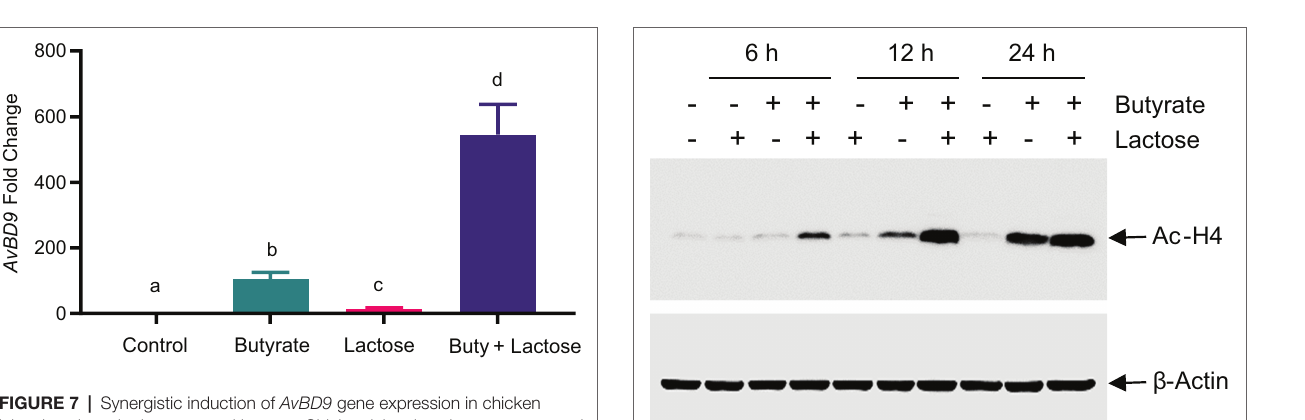
FIGURE 7 | Synergistic induction of AvBD9 gene expression in chicken jejunal explants by butyrate and lactose. Chicken jejunal explants were treated in duplicate with 2 mM sodium butyrate and 0.1 M lactose individually or in combination for 24 h, followed by RNA isolation and RT-qPCR analysis of AvBD9 expression. Results are shown as means ± SEM of three independent experiments. The bars without common superscript letters denote statistical significance ( p < 0.05) as determined by one-way ANOVA and post hoc Tukey’s test.